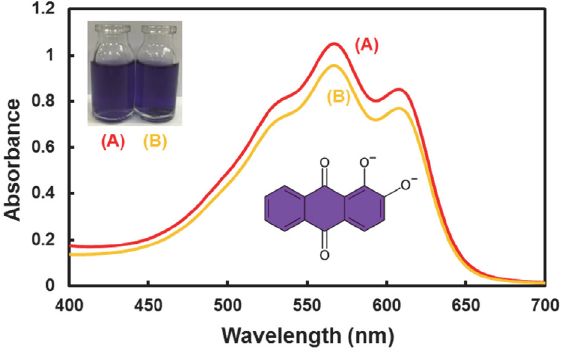
Figure 10. Absorption spectra of (A) 0.1 mM AZ and (B) 0.1 mM AZ in the presence of 0.001 g GO/PAMAM. The molecular struc- ture of AZ at pH = 12 is shown in this